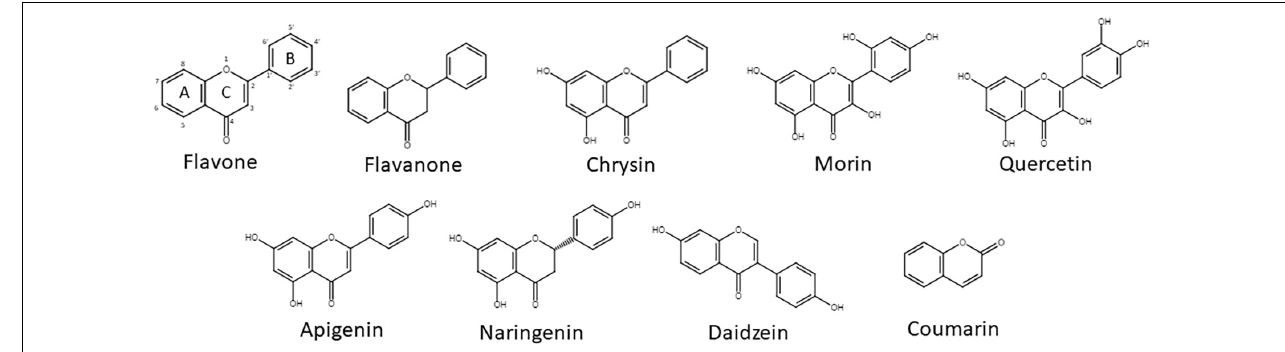
FIGURE 1 | SPMs used in this study. The numbering of atoms is shown, as well as the designation of the A-, B-, and C-rings in the flavone structure.